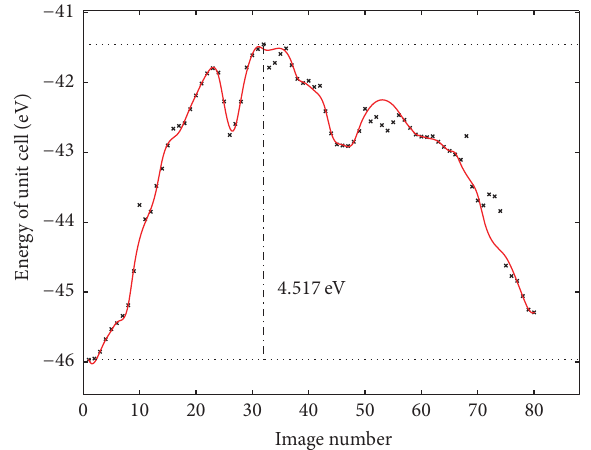
Figure 3: Progression of unit cell energies of structures forming a transition pathway between states of ZnSnS 3 . Path begins with a stable structure exhibiting space group 4 symmetry and ends with one having space group 161 symmetry. The initial and maximum energies are used to estimate the energy barrier to transition.